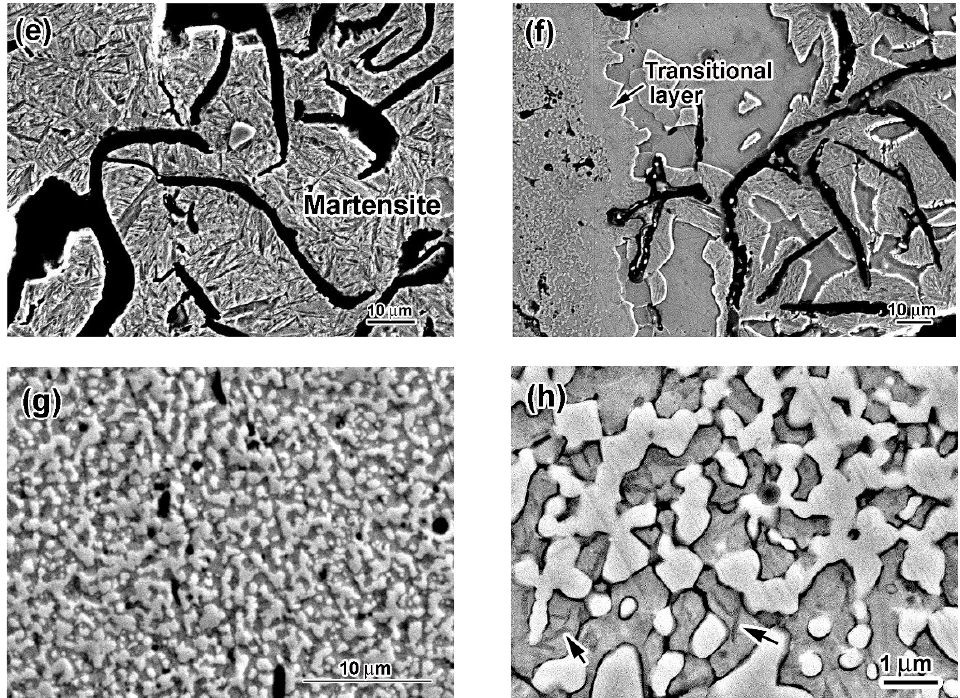
Figure 1. ( a , b ) Initial microstructures of gray cast iron and the 28 wt.%Cr cathode, respectively. ( c ) Microstructure of the as-deposited coating. ( d ) Near-surface structural zones in the heat-treated specimen. ( e ) Needle-shaped martensite and graphite lamellae in zone C. ( f ) Ferrite/martensite zone adjacent to the transitional layer. ( g , h ) Carbides in the coating.